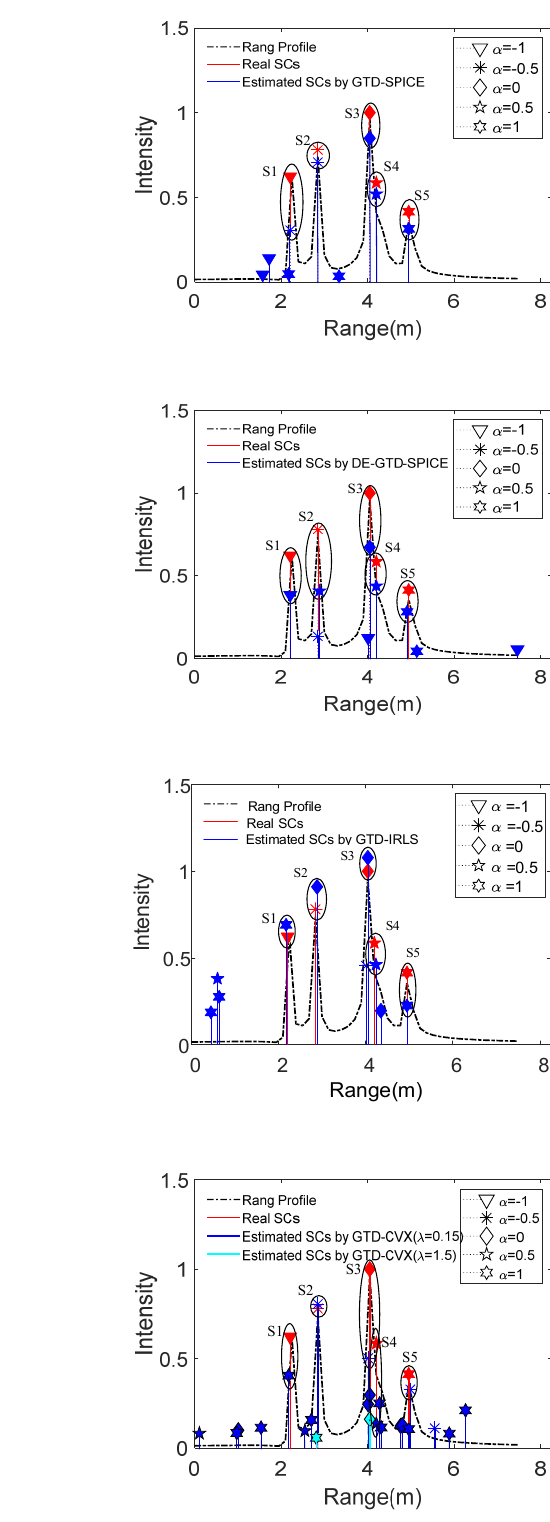
Figure 5. SPE results of the GTD–SPICE, DE–GTD–SPICE, GTD–IRLS, and GTD–CVX method. In this case, FHR = 60%, η = 0.1, and L Coarse = L Fine = 2 in the DE–GTD–SPICE method.